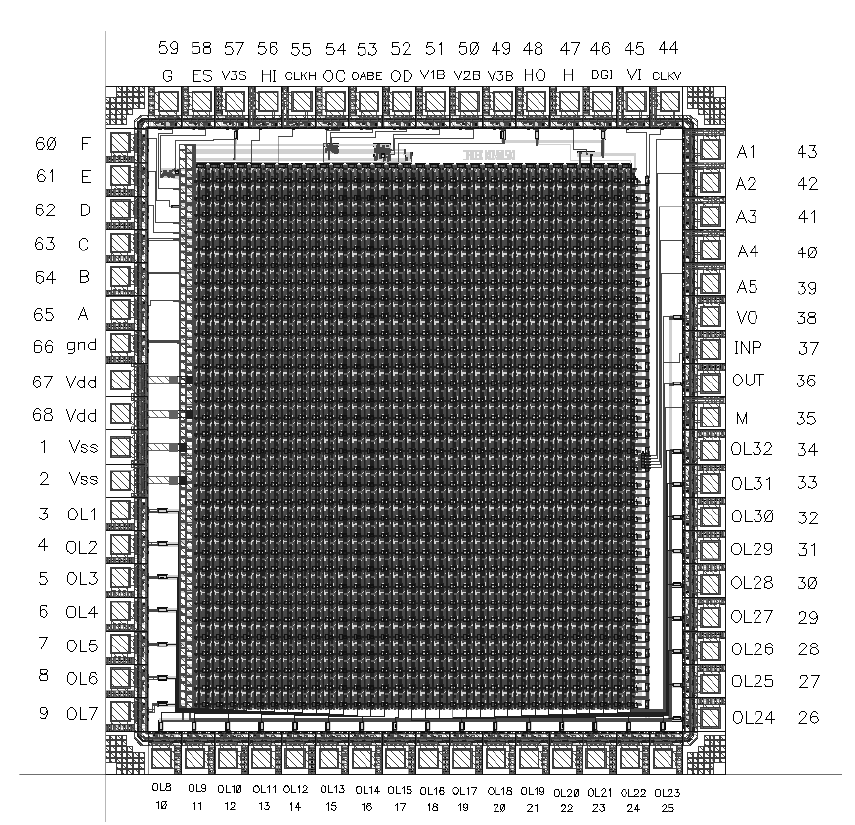
Figure 7. A layout of SON